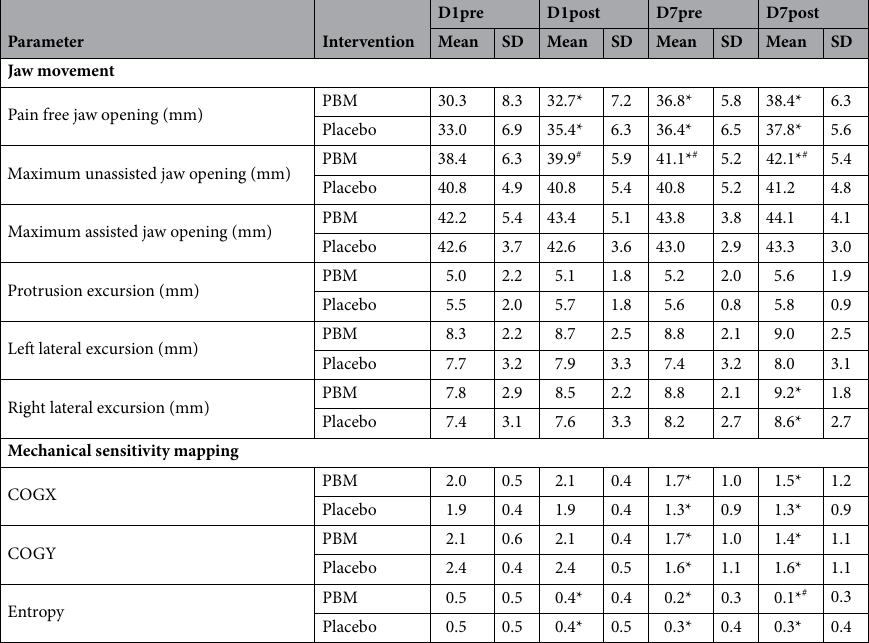
Table 3. The descriptive statistics (mean ± standard deviation) and results of analysis regarding the test parameters of the TMJ arthralgia group during the experiment (n = 50). Photobiomodulation (PBM) (n = 25); Placebo (n = 25); “*” indicates significant difference between D1-pre and other time points (P < 0.05); “#” indicates significant differences between PBM and placebo (P <